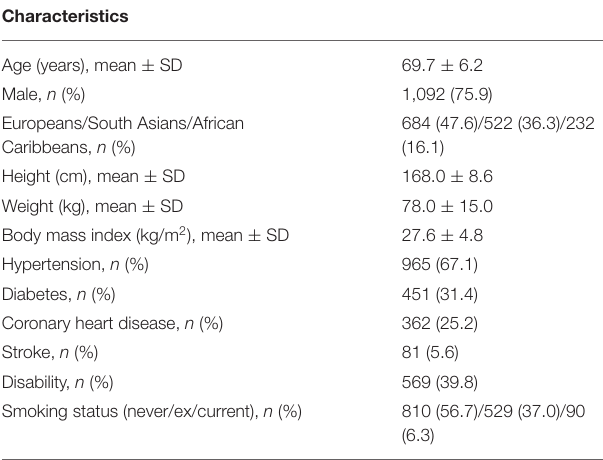
TABLE 3 | Characteristics of SABRE participants ( n = 1,438; visit